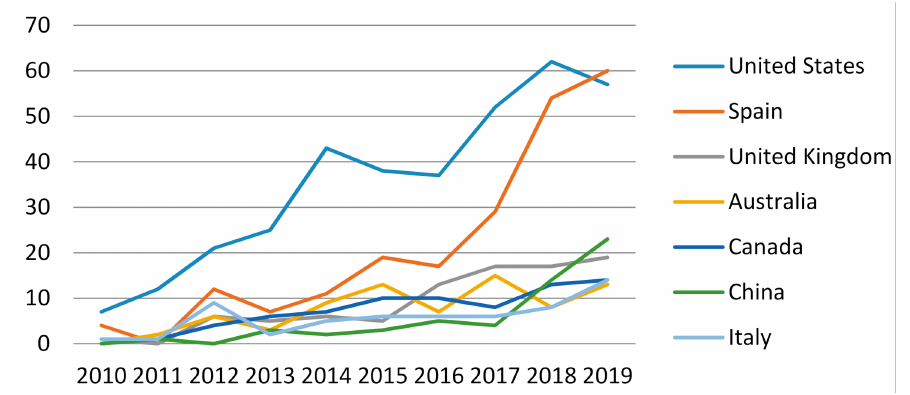
Figure 3. Trend in publications in countries with the highest production